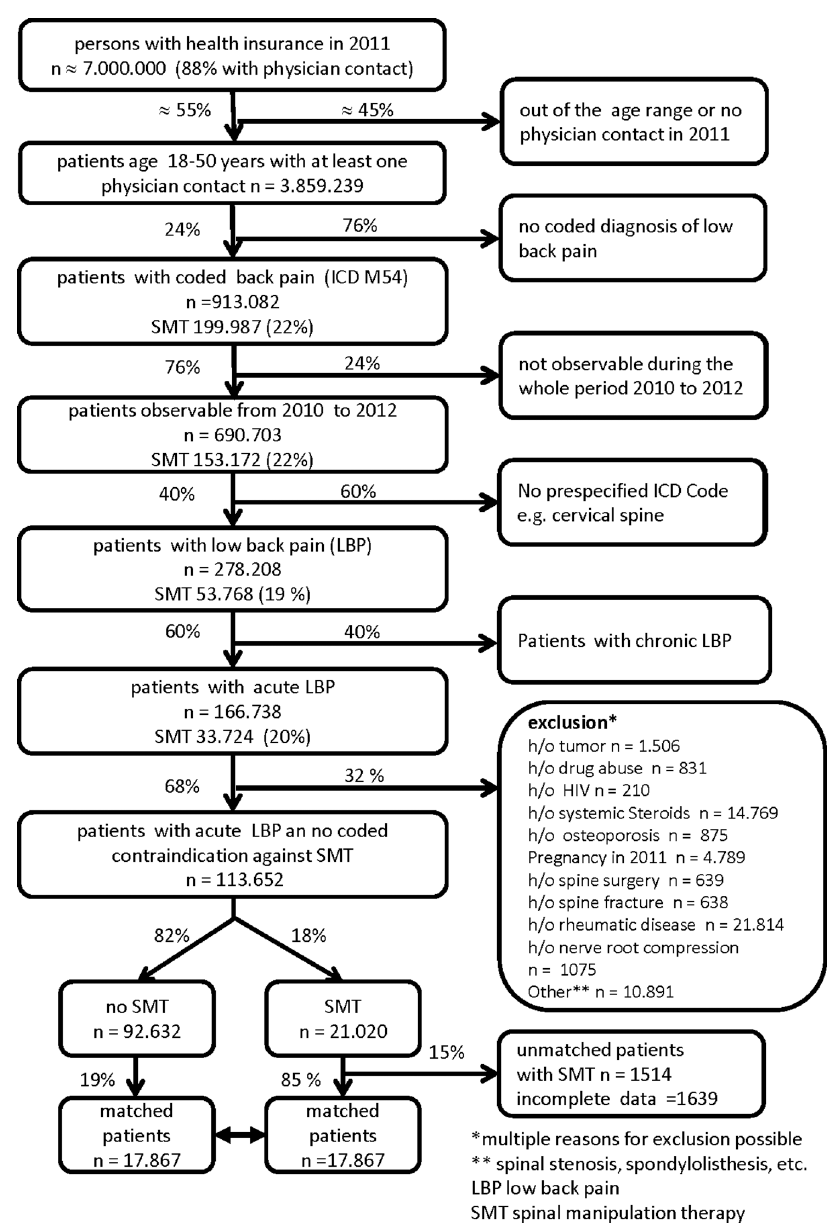
Fig 1. Study flow chart—selection of patients, casesand